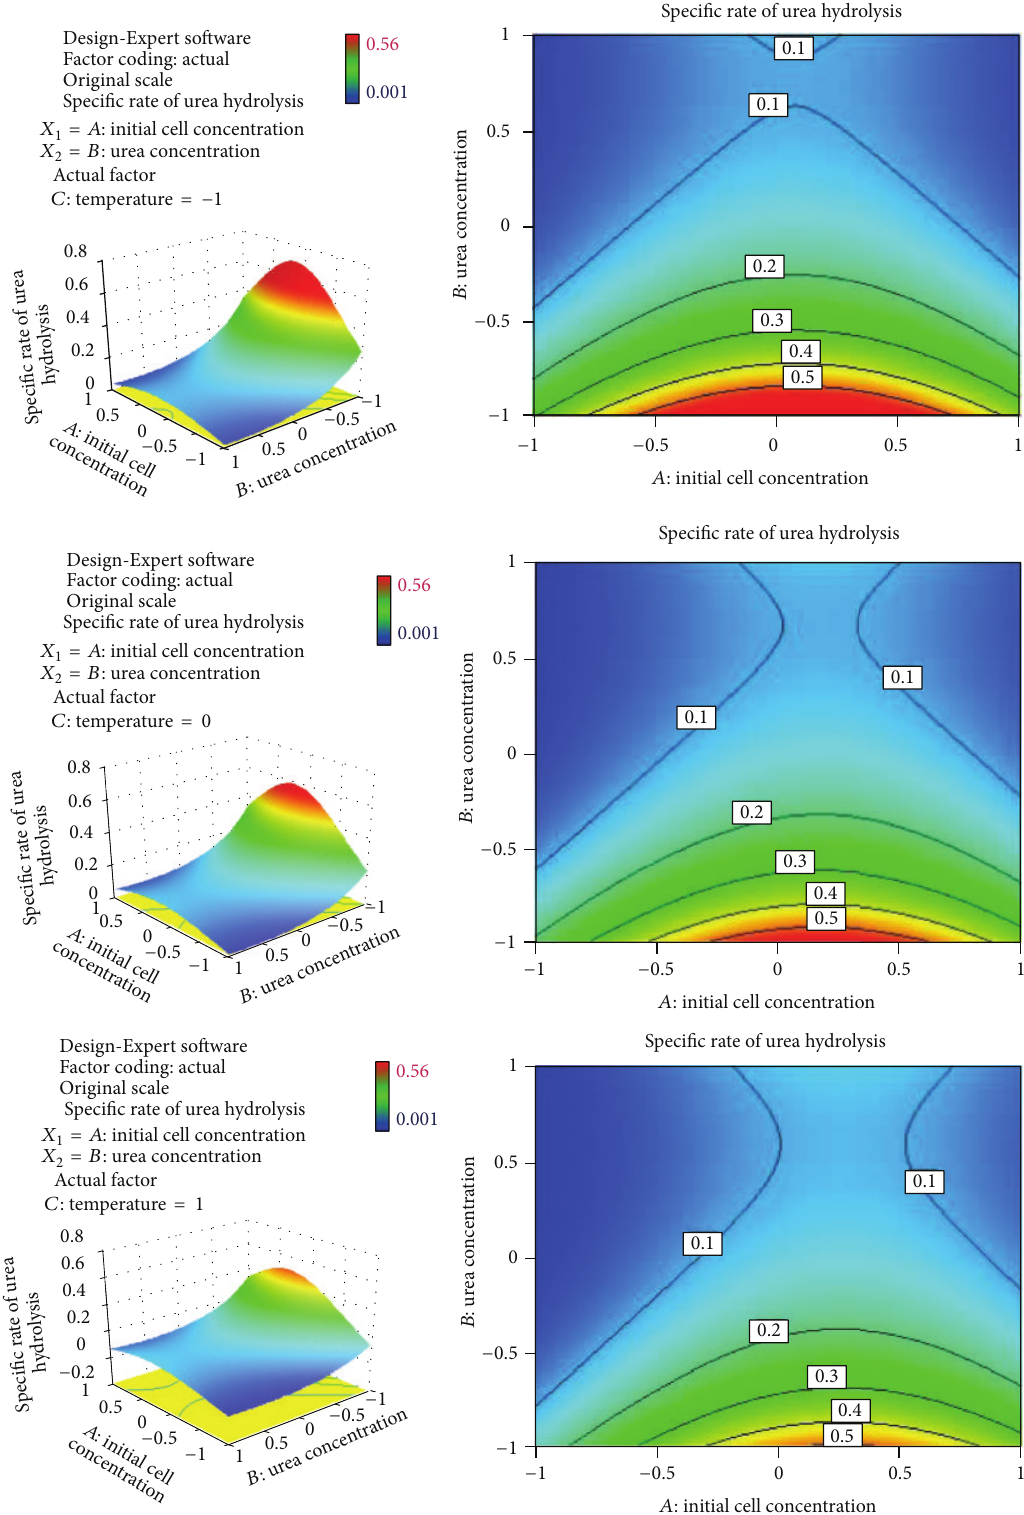
Figure 8: Response surface plots of the mutual effect of the factors on the specific urea hydrolysis